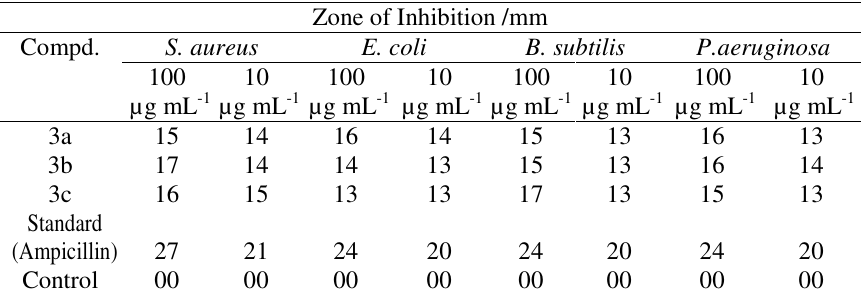
Table 1. Evaluation of antibacterial activity of the